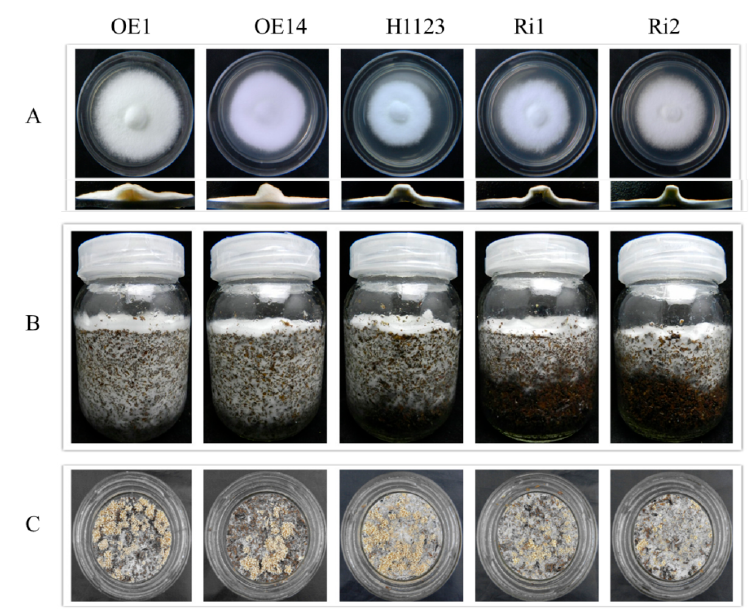
Figure 5. Phenotypic comparison of wild-type and Fv-JRL1 mutants. ( A ) Colonies and cross-sections of wild-type and Fv-JRL1 mutants after 5 days of incubation at 25 °C on potato dextrose agar (PDA) plates; ( B ) Growth after 22 days of incubation on composted substrate; ( C ) Fruiting trial.